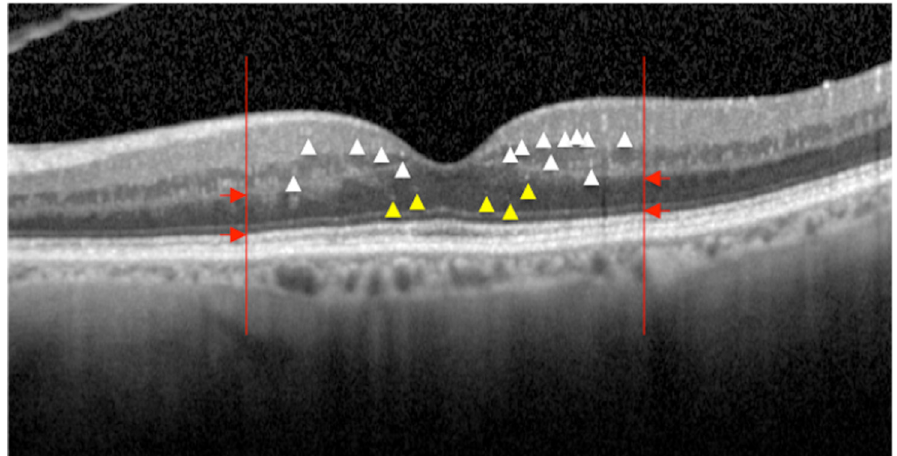
Figure 1. Linear spectral domain optical coherence tomography scan centered onto the fovea showing hyperreflective intraretinal foci (HRF) detection. The vertical red lines border the area where HRF are counted (3 mm length). The red arrows indicate the boundary between the inner retina (from the inner limiting membrane to the lower border of the inner plexiform layer) and the outer retina (from the upper limit of the outer nuclear layer and the boundary of the retinal pigment epithelium—Bruch’s membrane). White and yellow arrowheads indicate HRF in the inner and outer retina, respectively. Only HRF with small dimension ( ≤ 30 micron), intermediate reflectivity (similar to retinal nerve fiber layer) and no back-shadowing were considered.